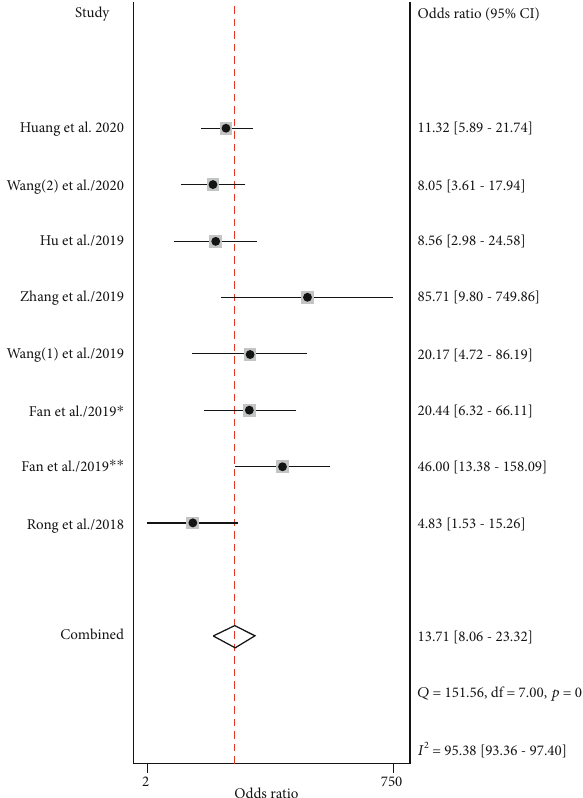
Figure 4: Forest plots of DOR of circRNAs for EC. DOR, diagnostic odds ratio; circRNAs, circular RNAs; EC, esophageal